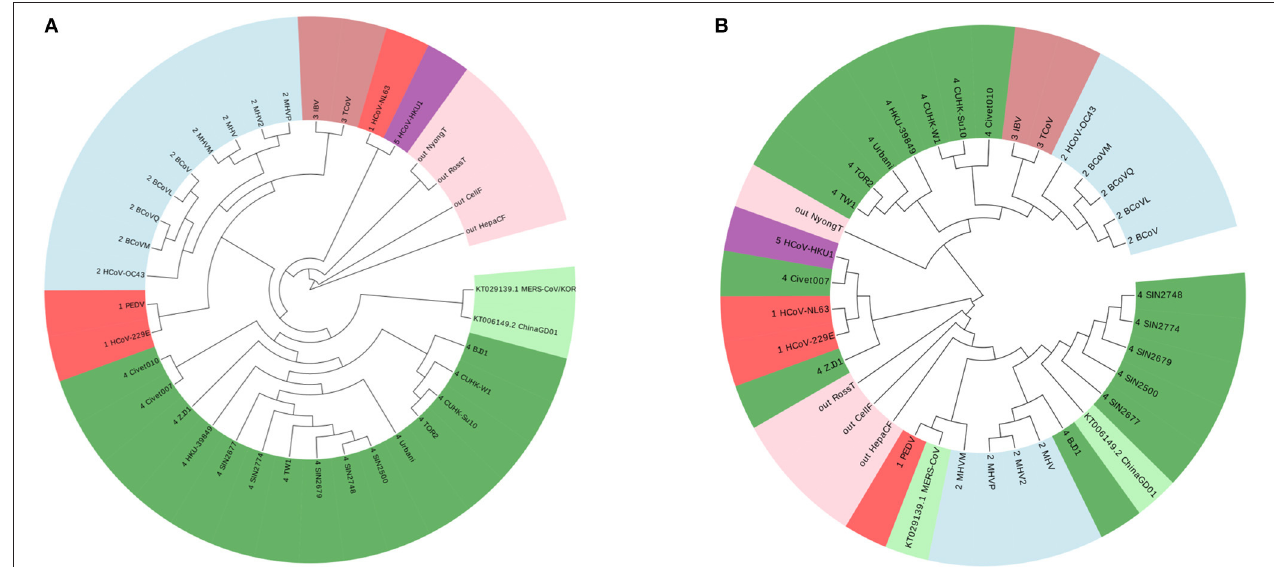
FIGURE 2 | (A) The phylogenetic UPGMA tree using FFP ( k-mer ) method when on Coronavirus dataset. (B) The phylogenetic UPGMA tree using MSA (ClustalW) method on Coronaviruses